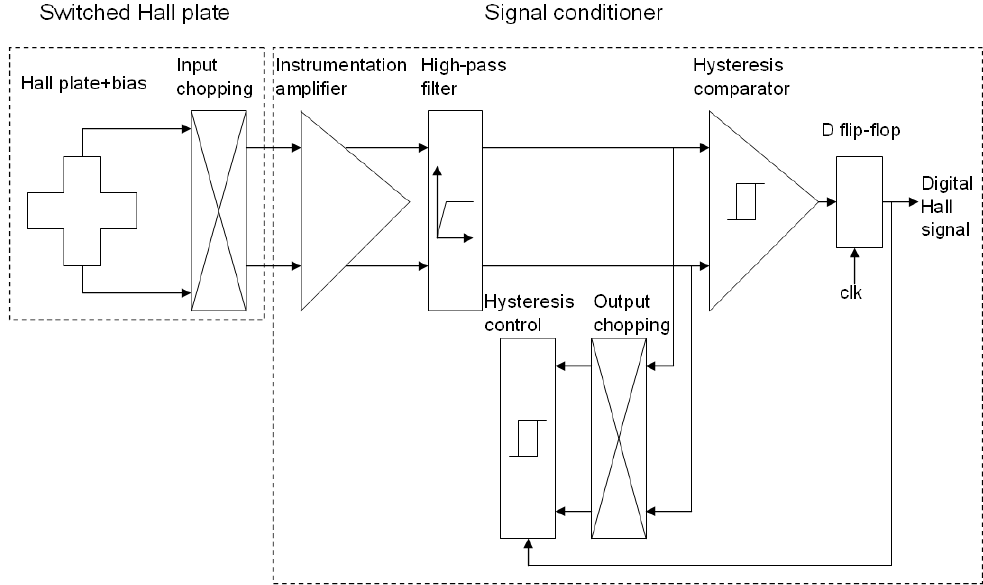
Figure 2. Block diagram of the new chopper stabilized instrumental